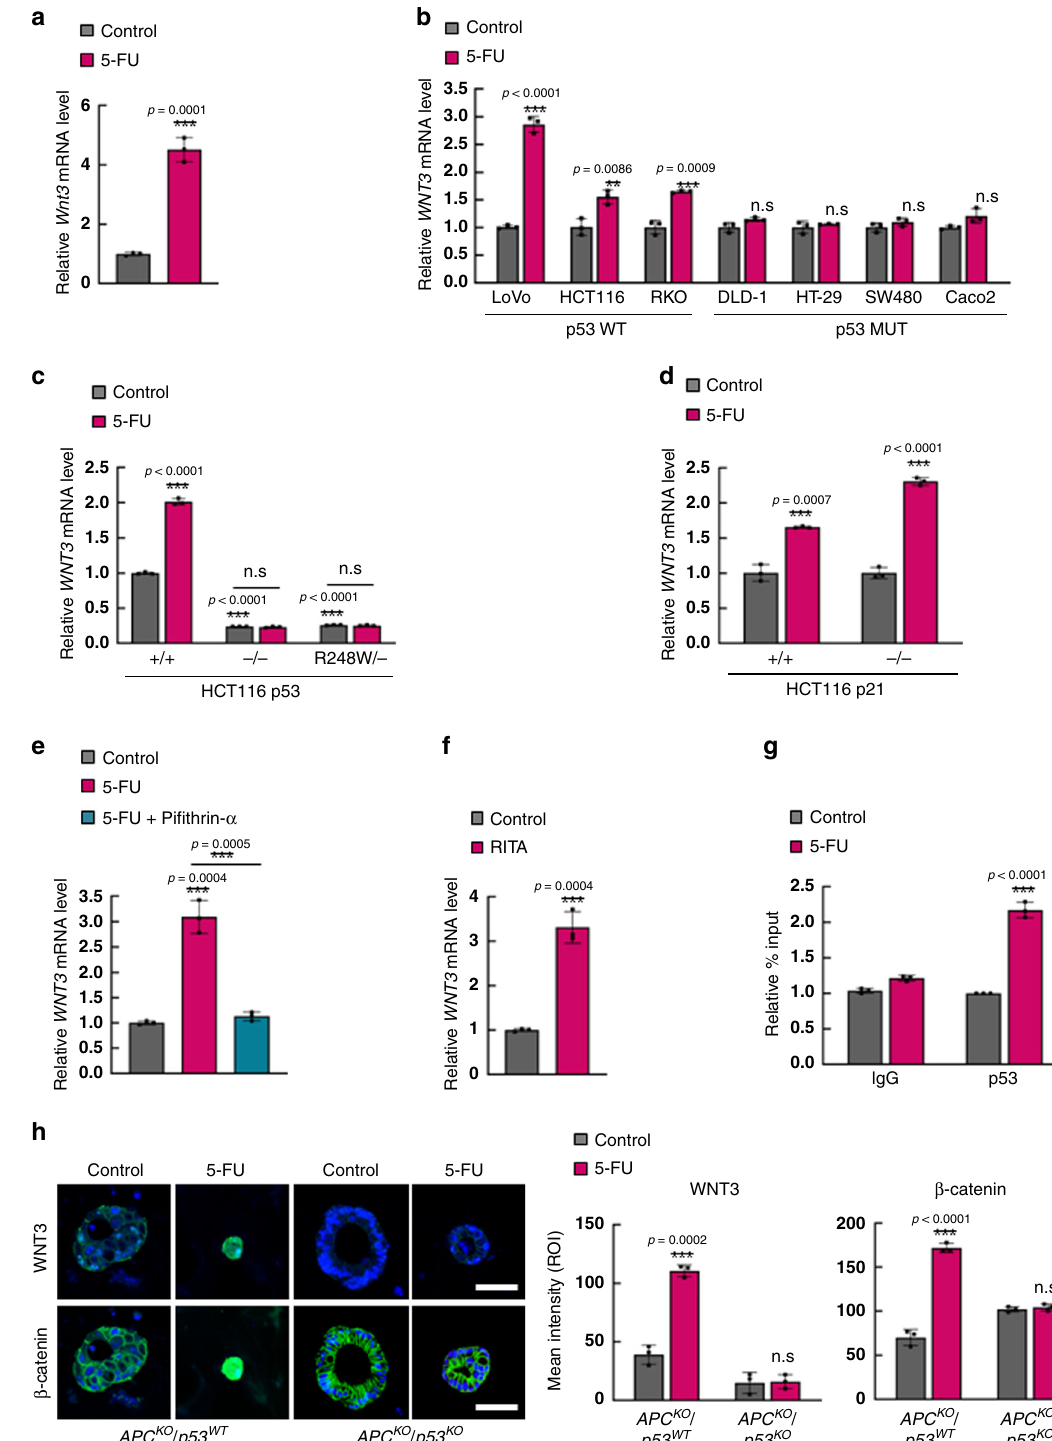
CD44, CD133, and CD166 CSC markers by 5-FU treatment and the inhibitory effects of LGK-974 on the 5-FU-induced activation of the WNT/ β -catenin signaling and subsequent CSC activation (Fig. 5i). Therefore, CSC activation via p53-mediated WNT3 induction is important for the 5-FU-induced recurrence of CRC. WNT inhibition suppresses the regrowth after 5-FU treatment